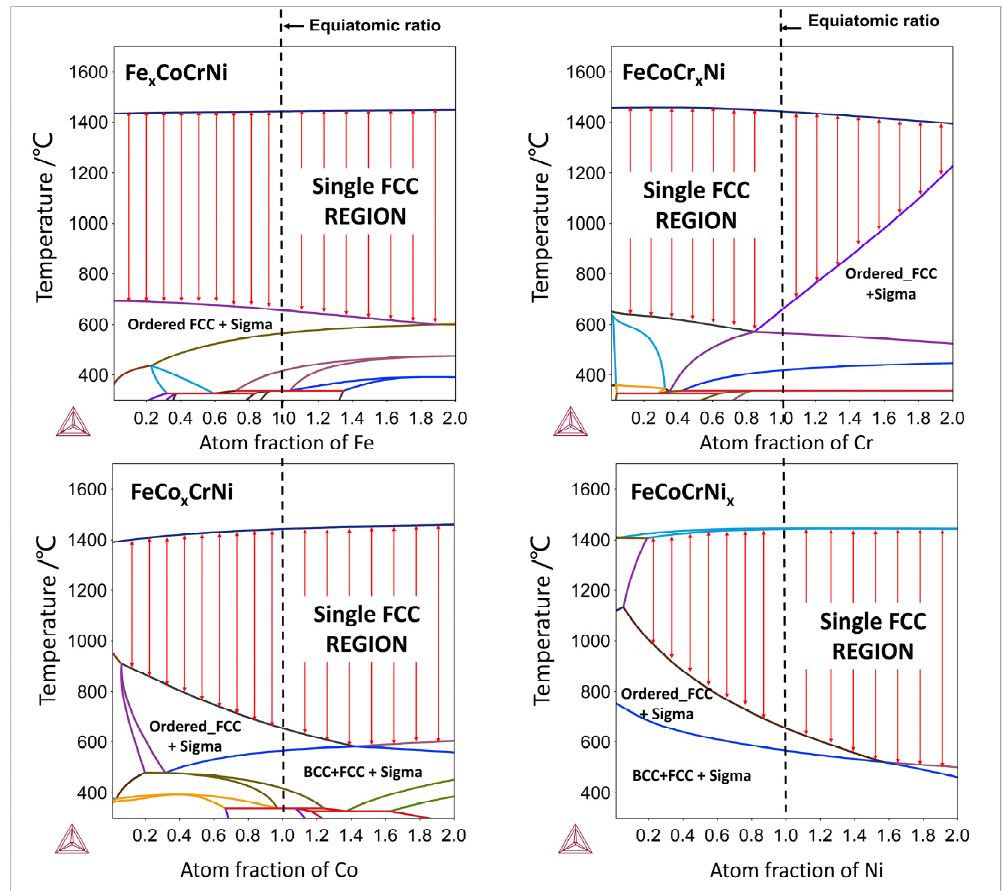
Figure 8. Calculated phase diagram of FeCoCrNi HEAs.